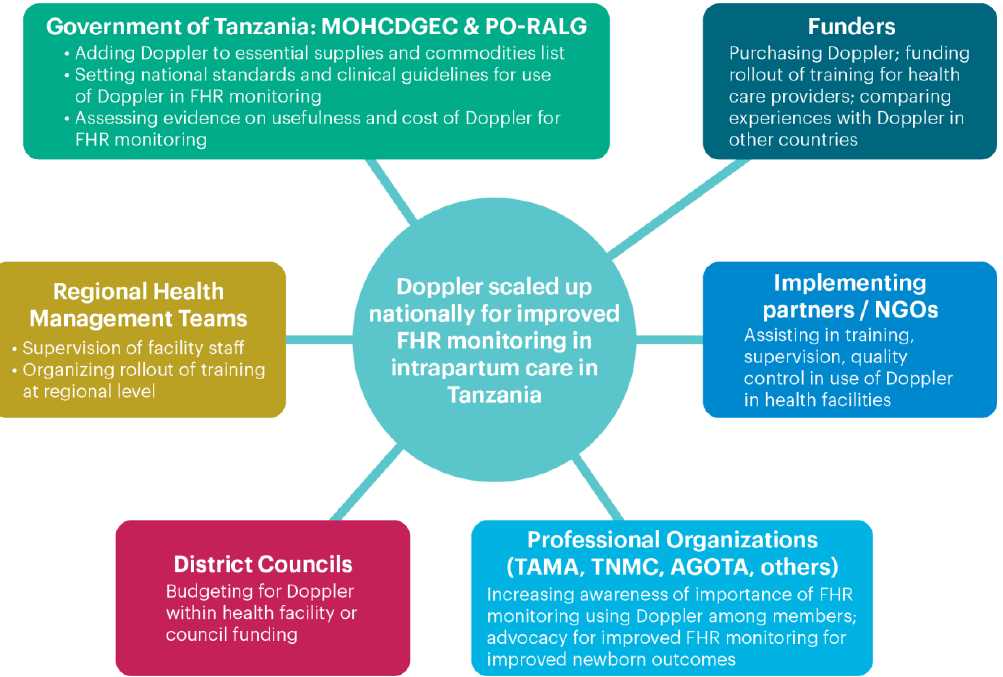
Figure 2. Roles and responsibilities of at policy, organizational, and subnational level for scale-up of